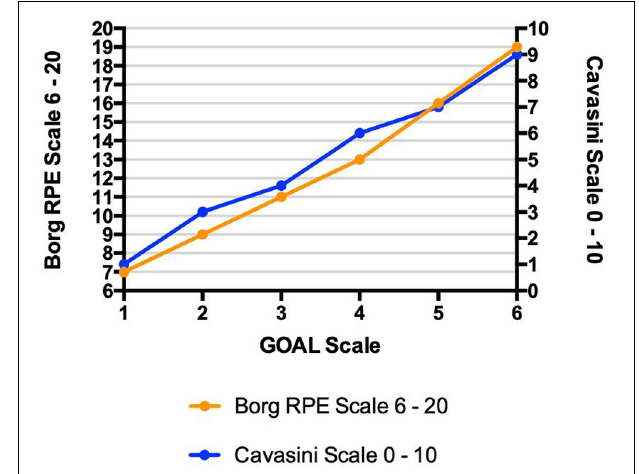
FIGURE 3 | Maximal cardiopulmonary effort test – Construct validation values of Borg RPE Scale and Cavasini Scale for each value of GOAL Scale. Relationships among rating of perceived exertion identified by three different instruments (GOAL Scale, Borg RPE Scale, and Cavasini Scale) during maximal incremental cardiopulmonary test; • r 2 = 0.86; • r 2 = 0.83.